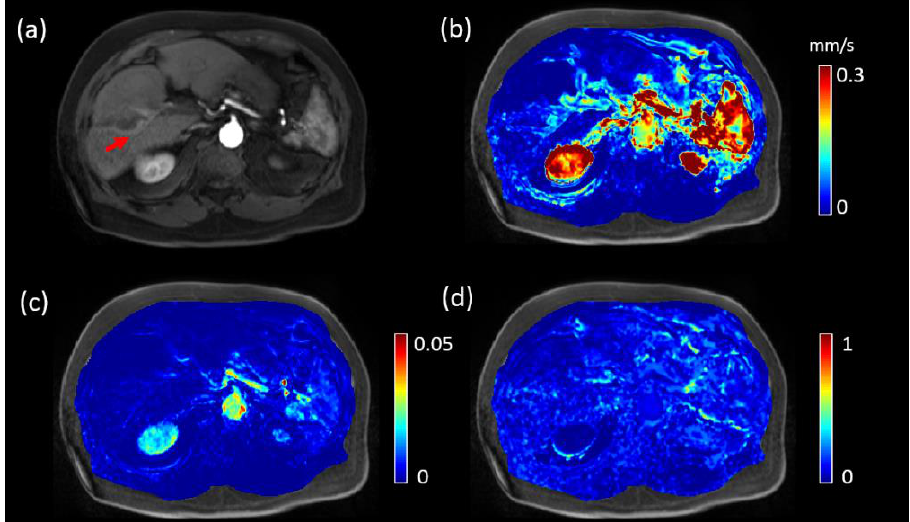
Figure 1. DCE MRI, QTM velocity, 𝐾 𝑡𝑟𝑎𝑛𝑠 and 𝑉 𝑒 maps of HCC of a 74-year-old patient with lung shunting fraction 9.3%. ( a ) post-Gd T1 weighted image showing the tumor (red arrow). ( b ) QTM |𝒖| map, ( c ) 𝐾 𝑡𝑟𝑎𝑛𝑠 map , and ( d ) 𝑉 𝑒 map.